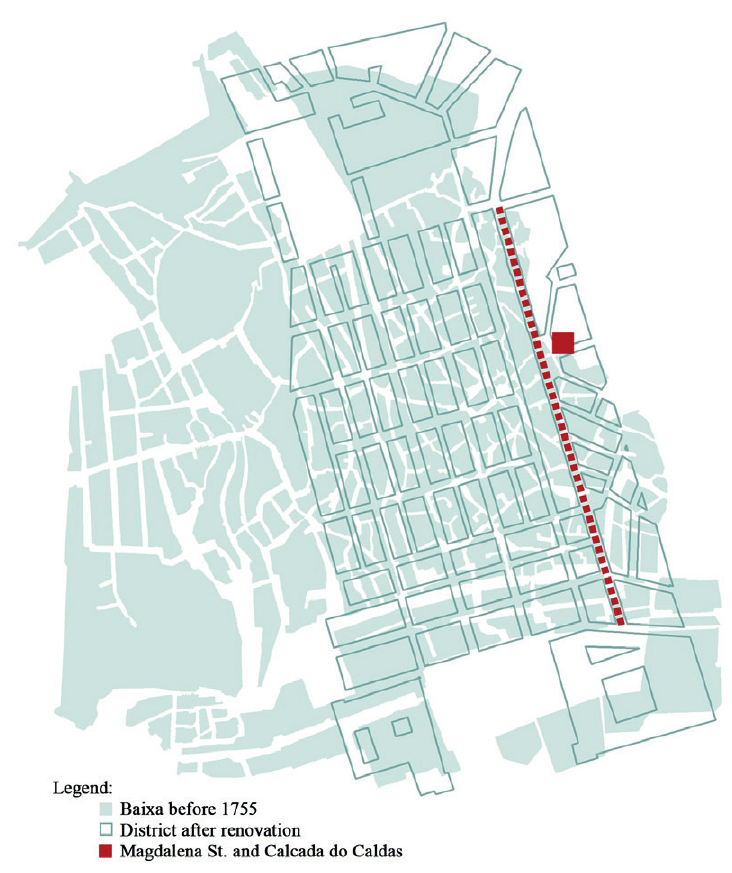
Figure 1. Comparison of Baixa district before the earthquake and after the renovation. Indication of Rua da Madalena in the city structure (source: authors’